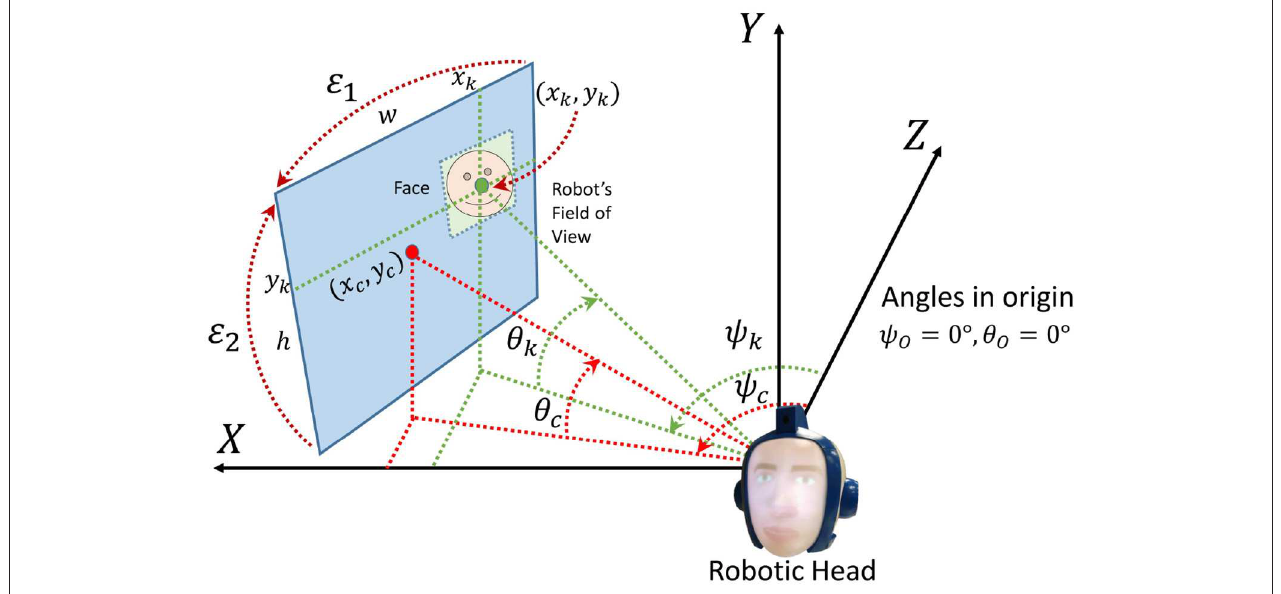
FIGURE 7 | Transformation of the coordinates of a face into angles of the